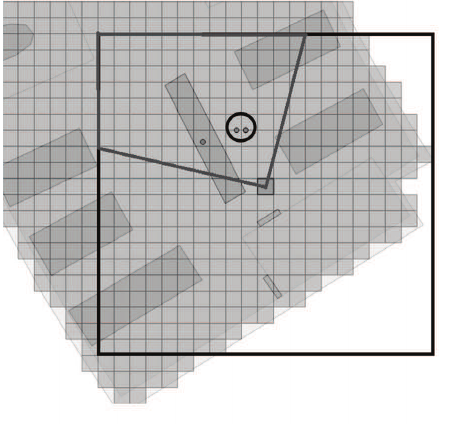
Figure 5: The Selection of measured locations (topology), and inside a certain buffer of previous determined lo- cation